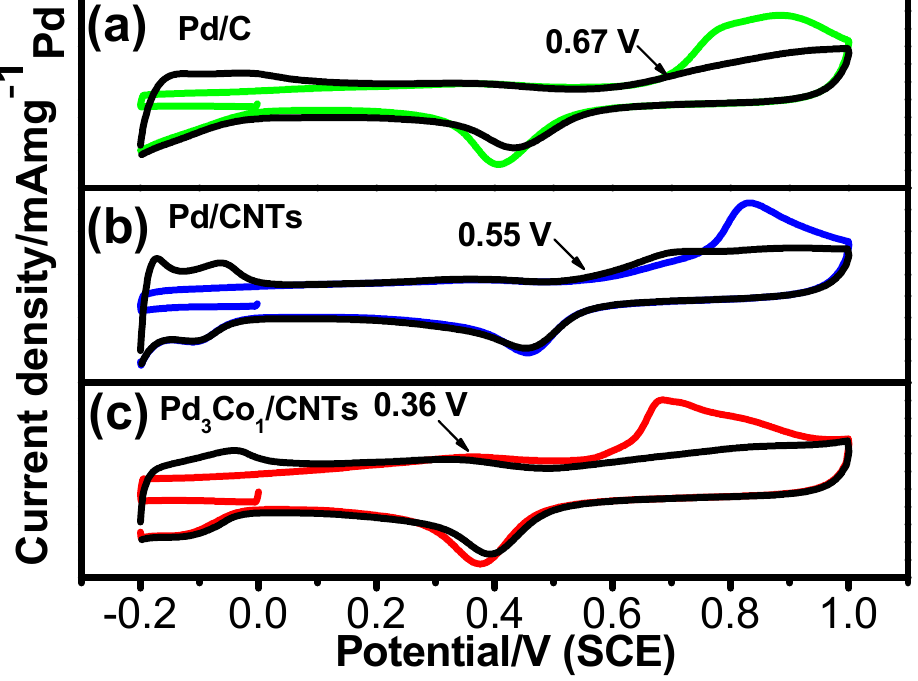
Figure 5. CO stripping voltammograms of Pd/C ( a ), Pd/CNTs ( b ), and Pd 2 Ni 1 /CNTs ( c ) catalysts in 0.5 M H 2 SO 4 solution.